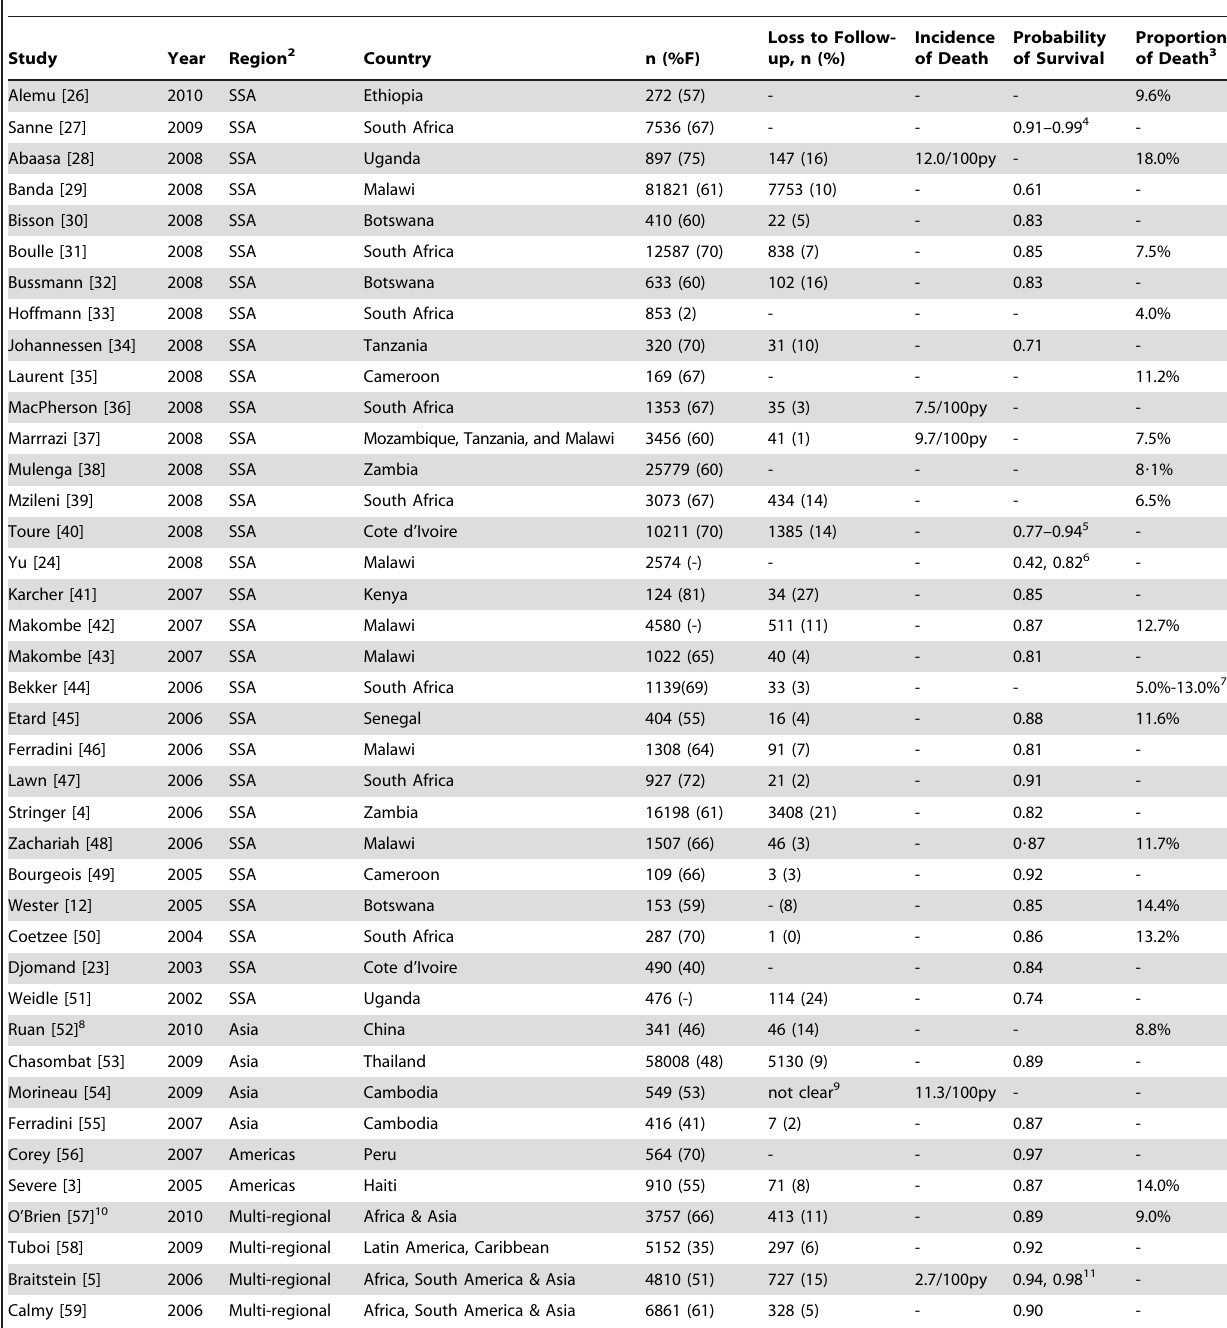
Table 1. Characteristics of included studies 1 and reported mortality and probability of survival at 12 months post-ART initiation by